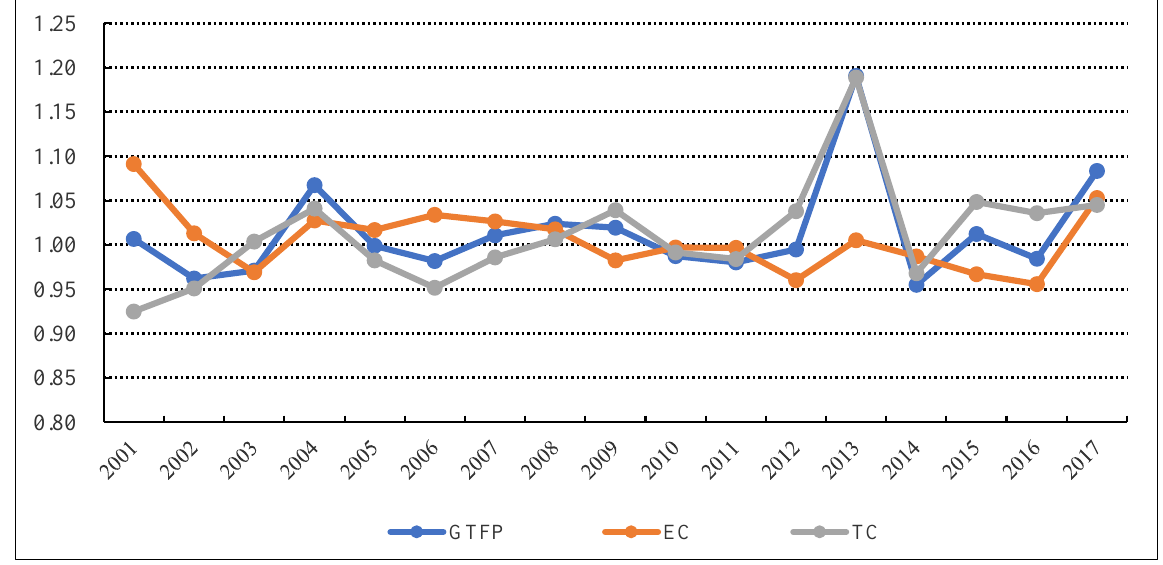
Figure 1. Evolution trends of GTFP of grain in Poyang Lake Basin from 2001 to 2017.